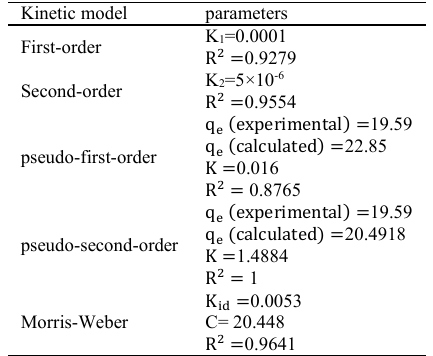
Table 4: Kinetic parameters for cadmium